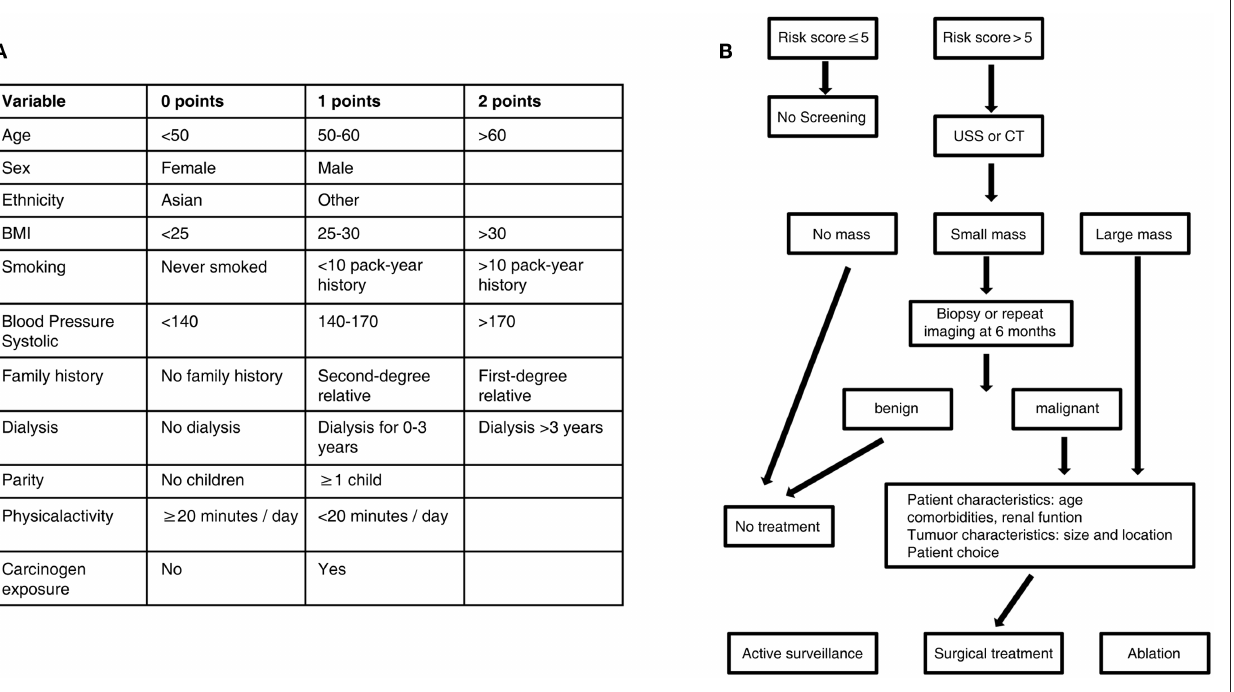
Figure 1 | Algorithm for targeted screening and treatment of renal cancer. (A) Patients are assigned a score based on known risk factors for renal cancer. (B) A score greater than five leads to screening by ultrasound or CT scan, while a score less than five does not lead to screening. A small renal mass identified on screening can be further characterized by biopsy or repeat